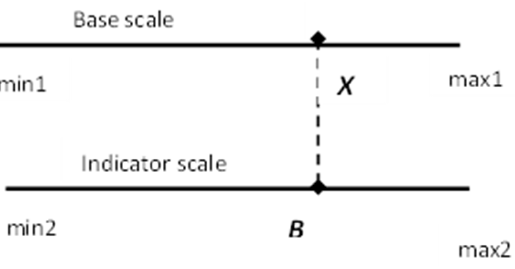
Figure 2. Base scales for score in points (source: designed by authors).